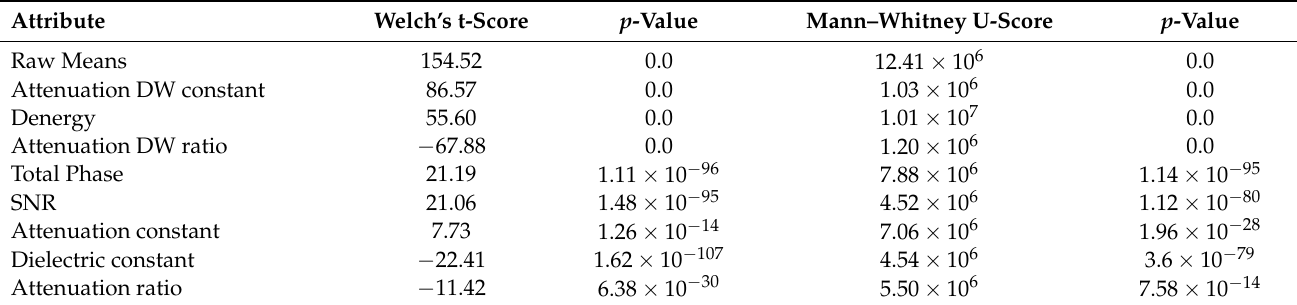
Table 4. Statistical comparison (with p -values) of the attributes for the northeast and southeast legs.